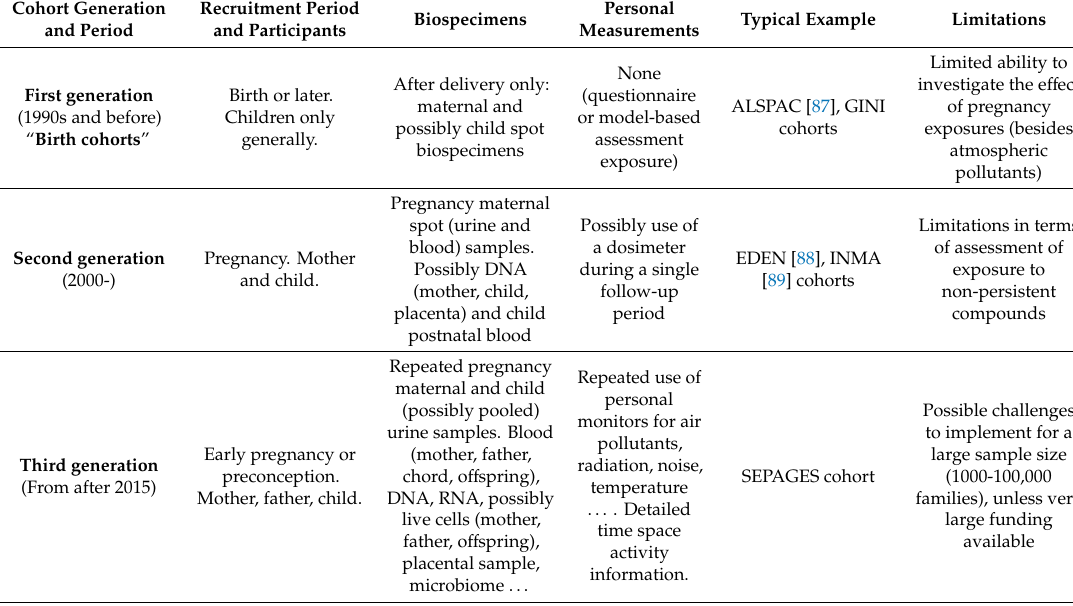
Table 6. Overview of the di ff erences in design between several generations of parents-child cohorts for environmental health. This represents a schematic view aiming at making evolutions more